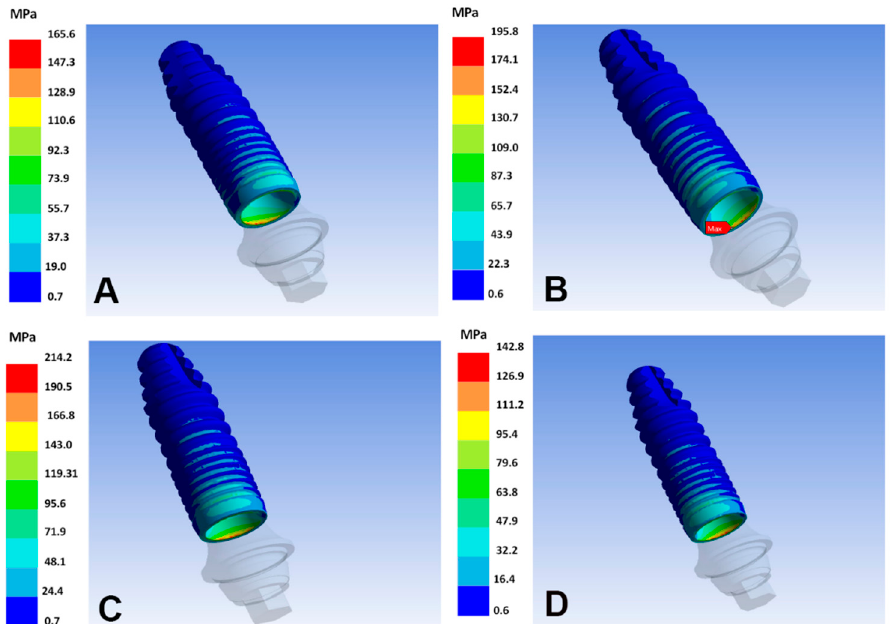
Figure 4. von Mises equivalent stresses in the implant surface of the different alloys. ( A ) T–6Al–4V; ( B ) Ti–26.88Fe–4Ta; ( C ) Ti–15Zr; ( D ) Ti–13Nb–13Zr.